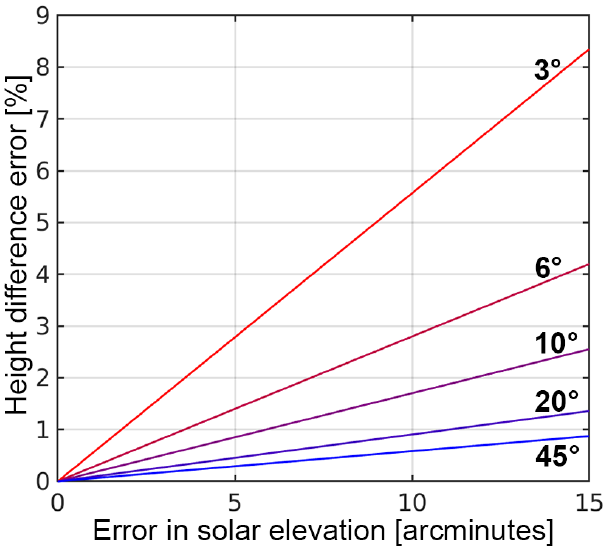
Figure 10. Relative error in shadow-derived height differences as a function of error in apparent solar elevation. Each line represents a different base value of solar elevation (3, 6, 10, 20, and 45